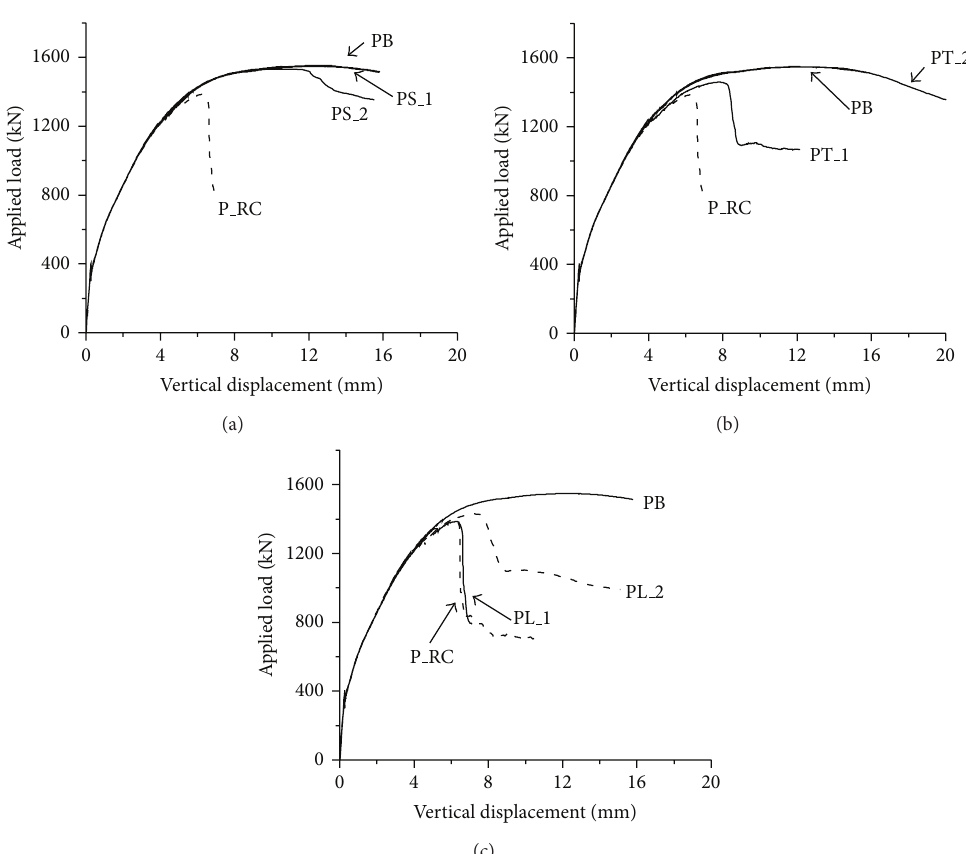
Figure 17: Results of parametric study (load-displacement relationship): (a) effect of the size of PSP; (b) effect of thickness of the PSP; and (c) effect of the location of